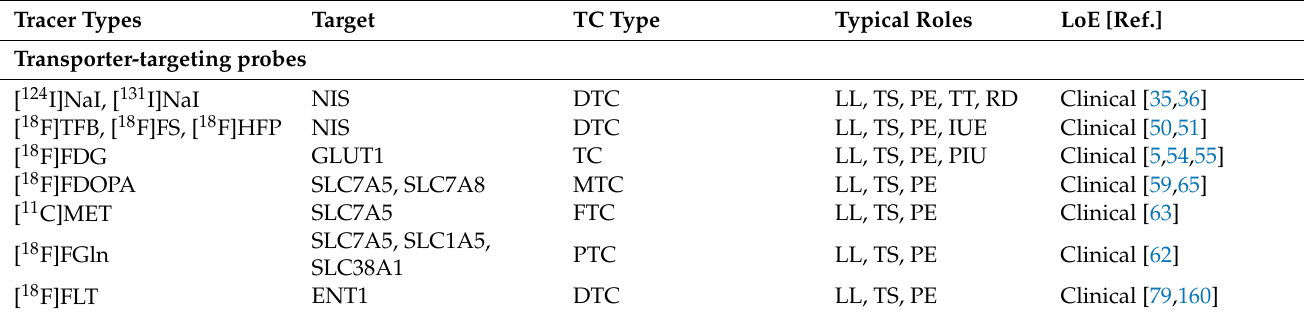
Table 1. A synoptic view of the MI radiotracers and their potential clinical